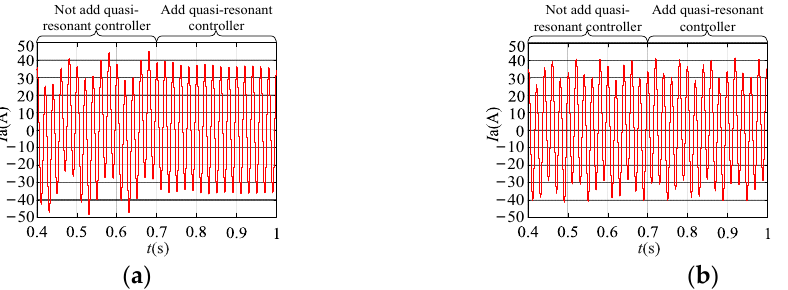
Figure 3. Influence of SSO frequency variation on DFIG system: ( a ) rid oscillation frequency of 10 Hz; ( b ) grid oscillation frequency of 15 Hz.